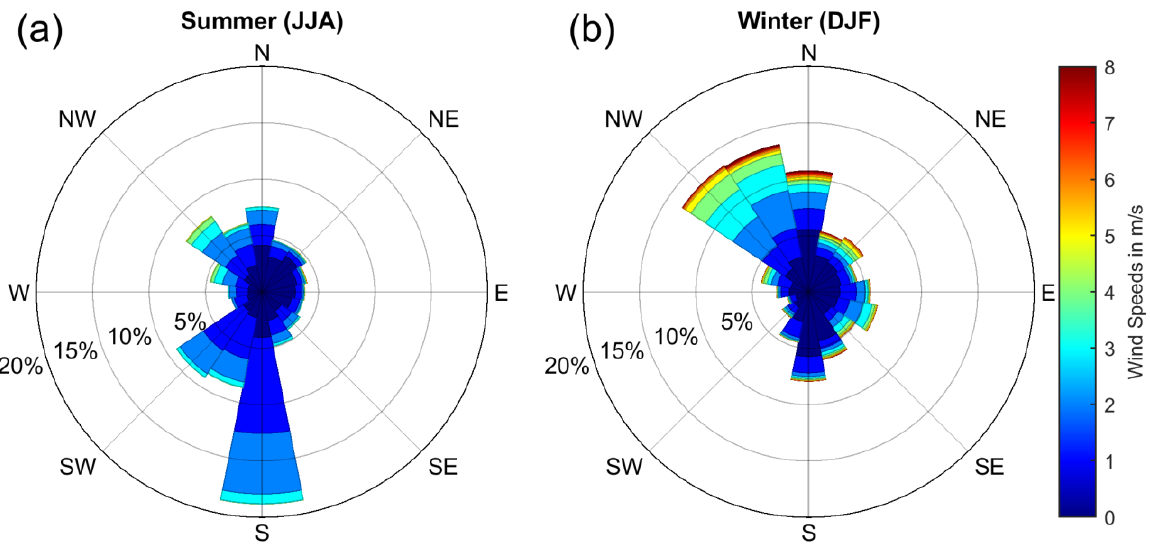
Figure A2. Wind rose diagrams (binned by 22.5°) over Thessaloniki during summer ( a ) and winter ( b ) for the period June 2020 to November 2022.